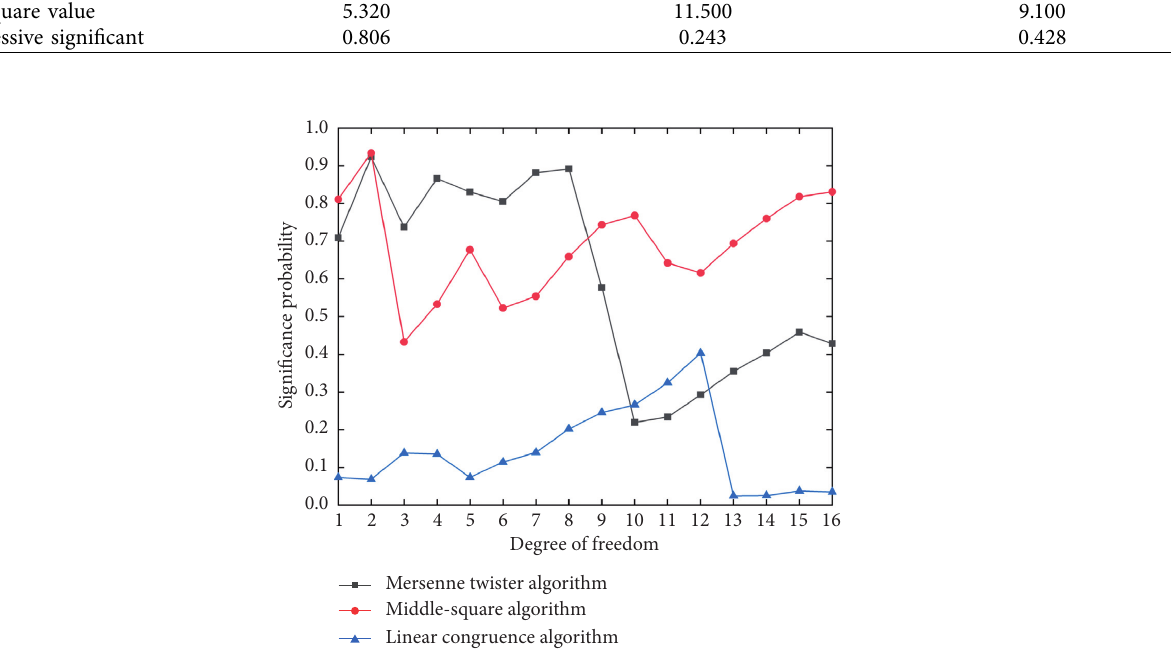
Figure 3: Significance level test of three methods.